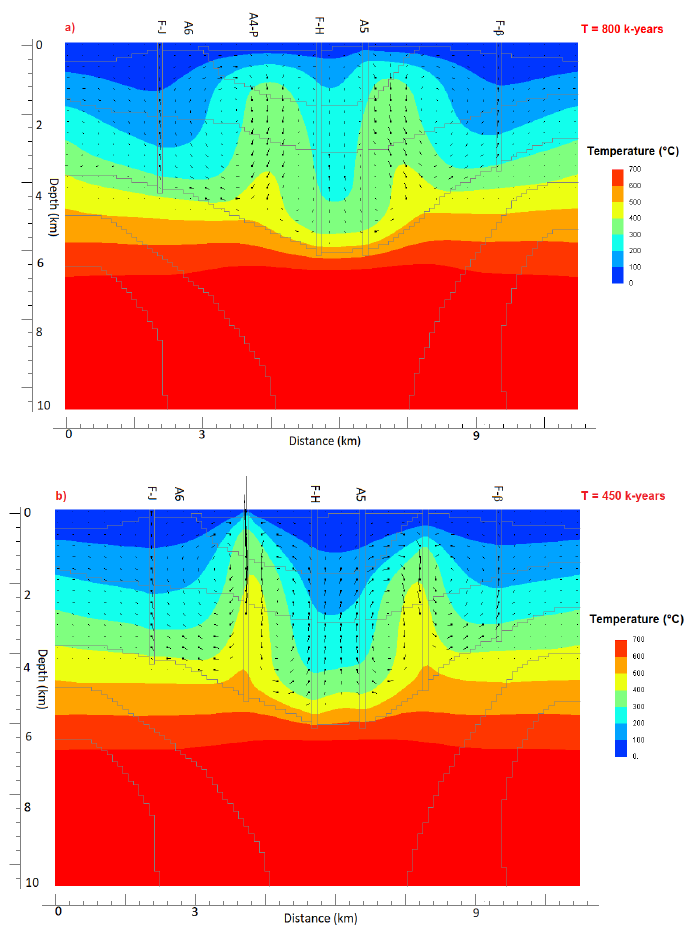
Figure A1. Simulated temperature and flow vectors for ( a ) scenario 2A at time 800,000 years and ( b ) the same scenario 2A with two additional minor faults (six faults instead of four faults) at time 450,000 years. The direction of flow is from the point to the end of straight lines. The length of each line indicates the water vector magnitude, where 1.2 km = 10 − 6 g s − 1 cm − 2